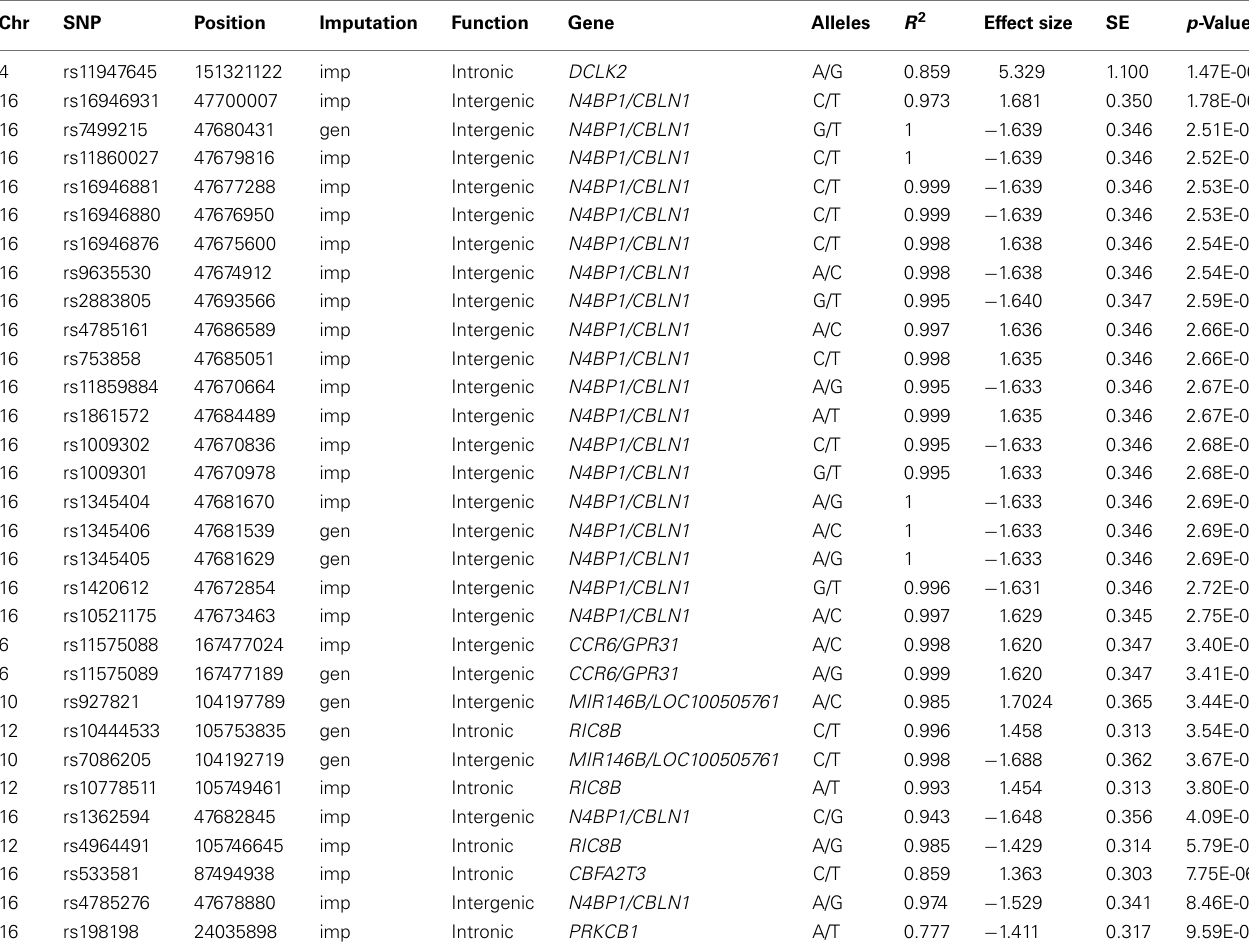
Table 2 |Association results for social skills ( p- value < 1.0 × 10 − 5